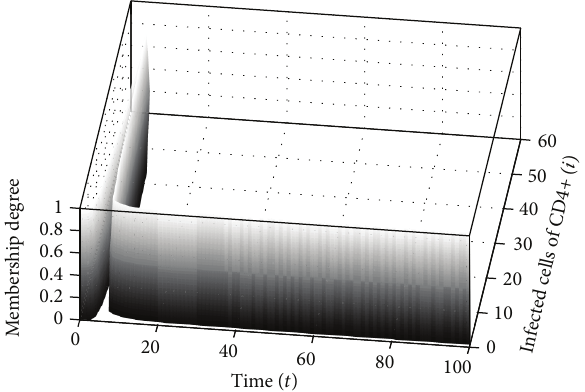
Figure 7: Fuzzy solution for infected CD4 + T lymphocytes of system (3).